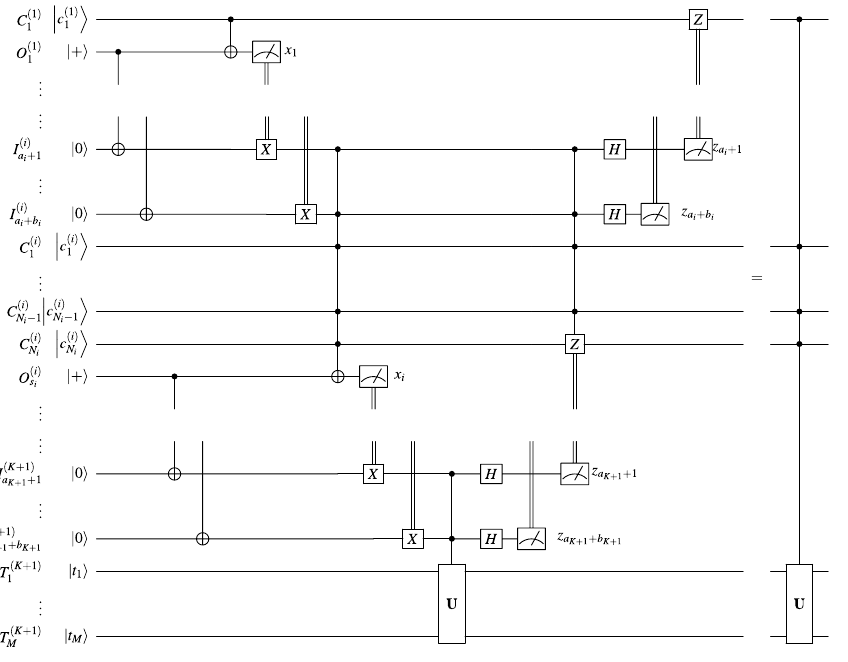
Figure 3. Parallel cascade distribution of controlled